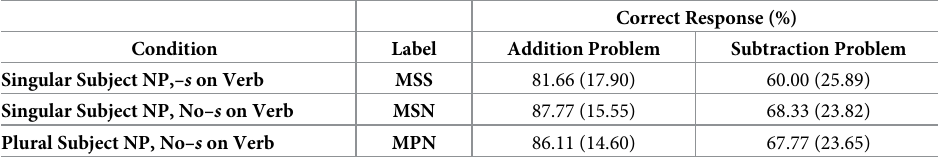
Table 12. Mean percent correct response (%) with SDs (in parentheses) for the math